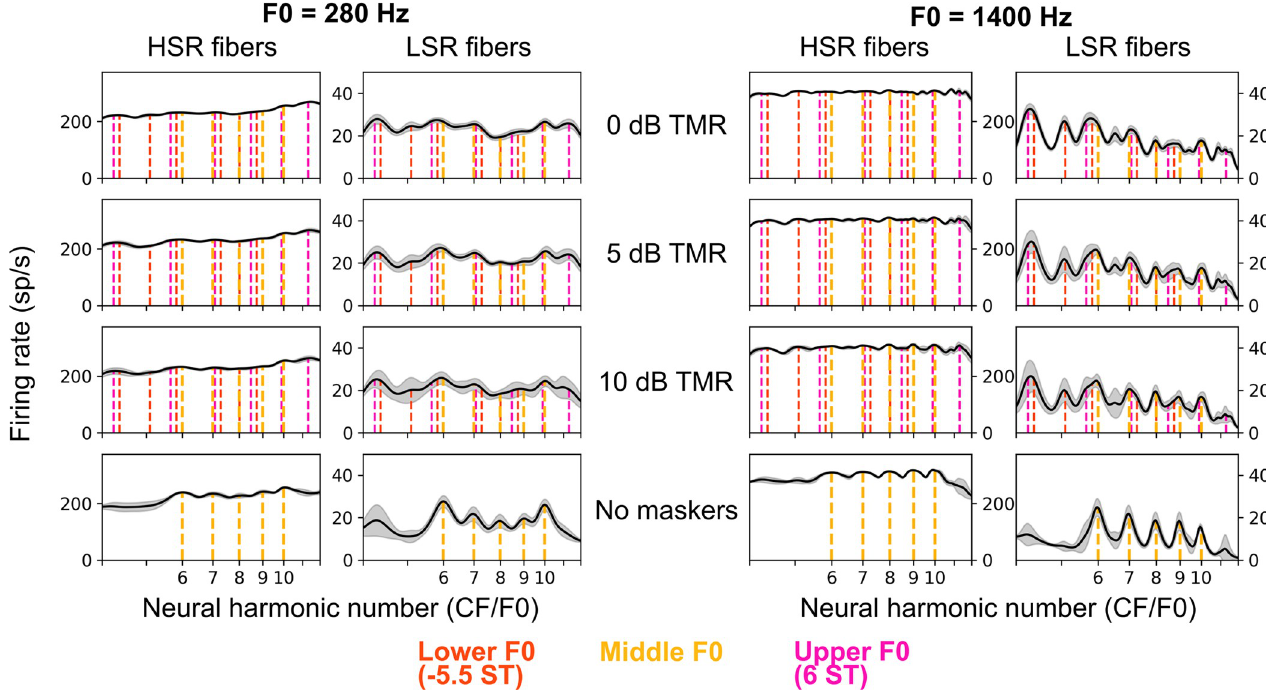
Fig 6. Comparison of excitation patterns at low and high frequencies for the DBL stimulus. Excitation patterns (average firing rate versus CF) for simulated high-spontaneous-rate and low-spontaneous-rate auditory-nerve fibers [52] responding to the low-frequency DBL stimulus (left column) and the high- frequency DBL stimulus (right column) in Experiment 2. The solid curve indicates the average excitation pattern while the filled area around the curve indicates ± 1 standard deviation (over 10 simulations with different samples of masking noise and level roving). Vertical dashed lines indicate the frequencies of target components and masker components. Color of the lines indicates which F0 they corresponding to (orange for the lower masker F0, gold for the target F0, and pink for the upper masker F0). See Materials and Methods for more details on the